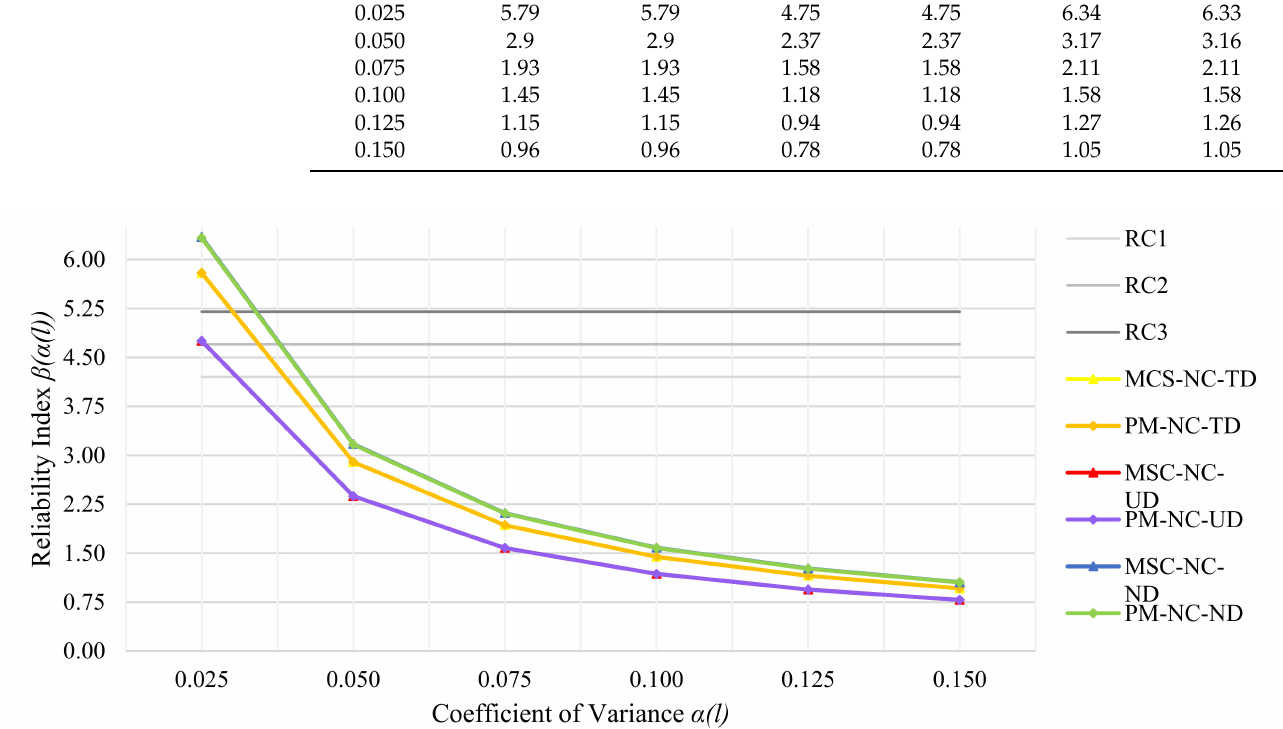
Table 8. A contrast of the reliability indices β in the SLS by numerical and analytical methods based upon the Monte Carlo simulation method and the stochastic perturbation technique for a various probability distribution. Distribution Triangular